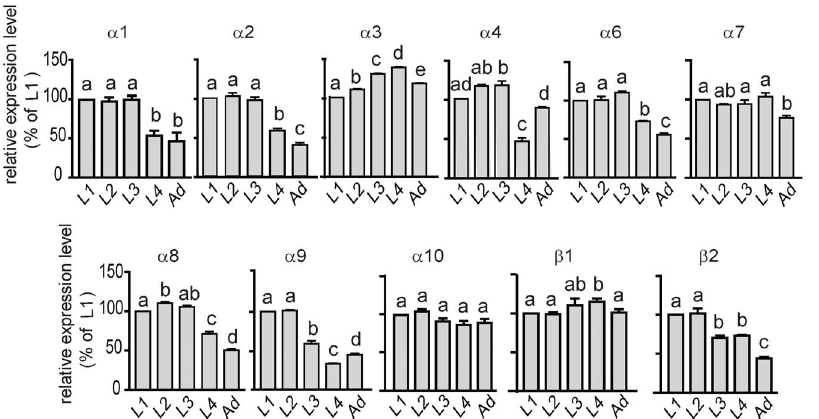
Figure 6. Expression level of nAChR mRNA subunits according to developmental stages of the pea aphid. Quantitative experiments were performed on whole individuals in triplicate. Results are mean of three independent experiments. Relative expression ratio were calculated relative to first-instar nymphs and normalized with external reference gene luciferase . Statistical analysis (One-Way ANOVA) was carried out using GraphPad Prism 5 software. For each subunit, expression ratio statistically different according to larval stage are designated by different letters.